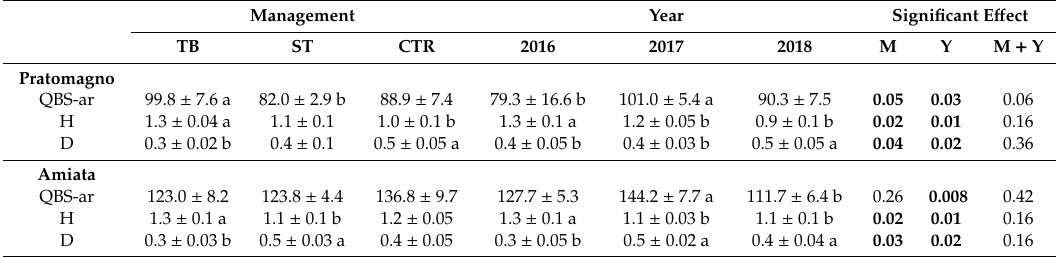
Table 4. E ff ect of di ff erent managements (M) on soil microarthropod indices through the years (Y). TB, thinning from below; ST, selective thinning; CTR, control without thinning; QBS-ar, soil biological quality-arthropods; H, Shannon-Weiner index; D, Simpson index. Standard errors ( ± ) are reported. Di ff erent letters indicate significant di ff erences at p < 0.05. Significant di ff erences are highlighted in